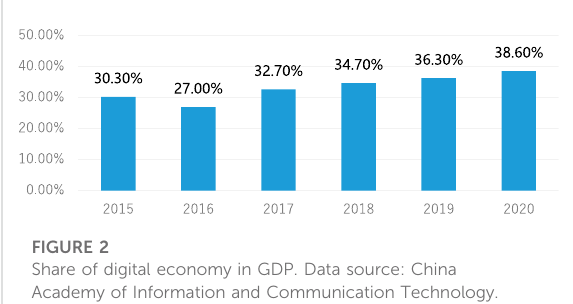
FIGURE 2 Share of digital economy in GDP. Data source: China Academy of Information and Communication